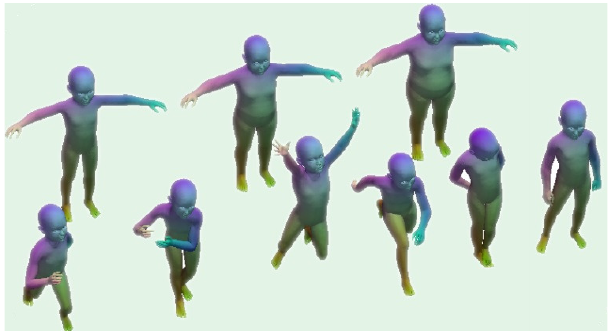
Figure 19. Examples from the Kidsdataset. The figure is originally from